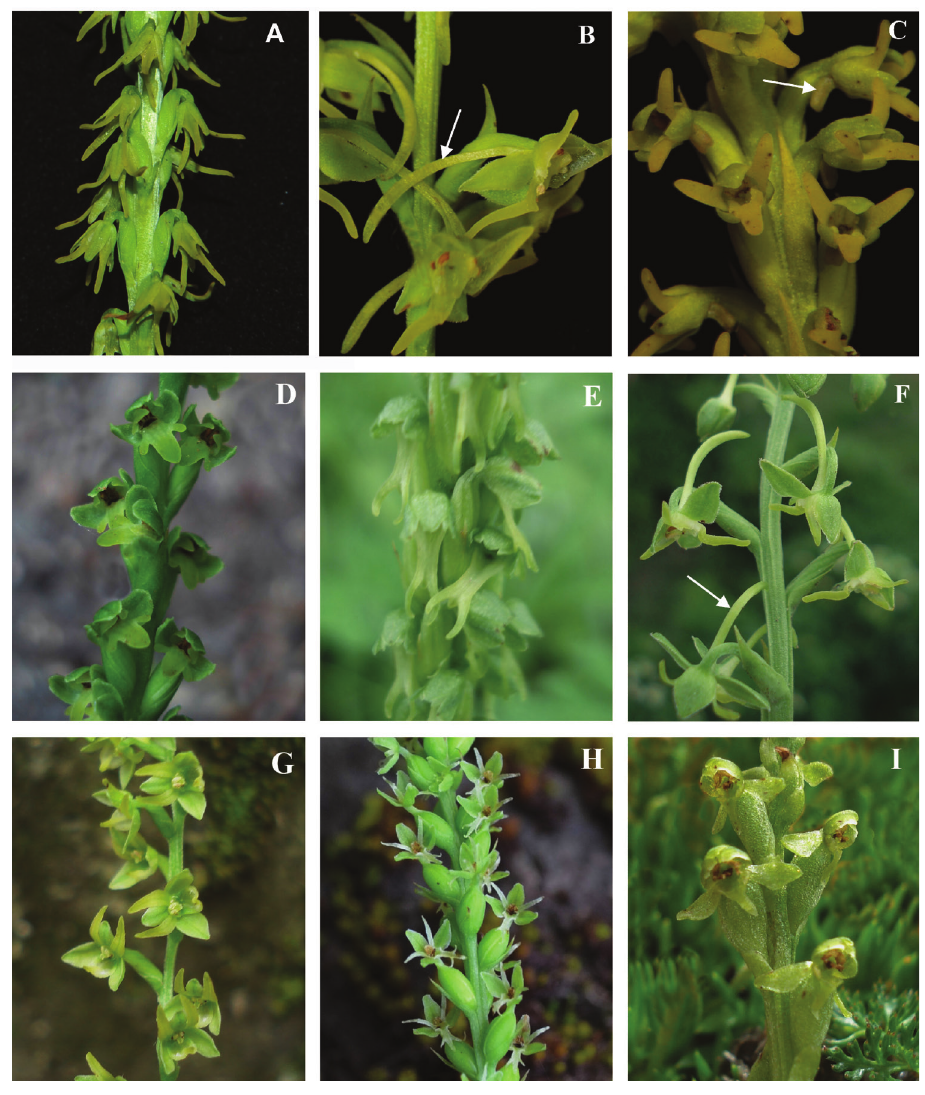
Figure 5. Flowers of representive species of Herminium . A H. monorchis B H. latilabre C H. forceps D H. fallax E H. lanceum F H. edgeworthii G H. monophyllum H H. quinquelobum I H. pugioniforme